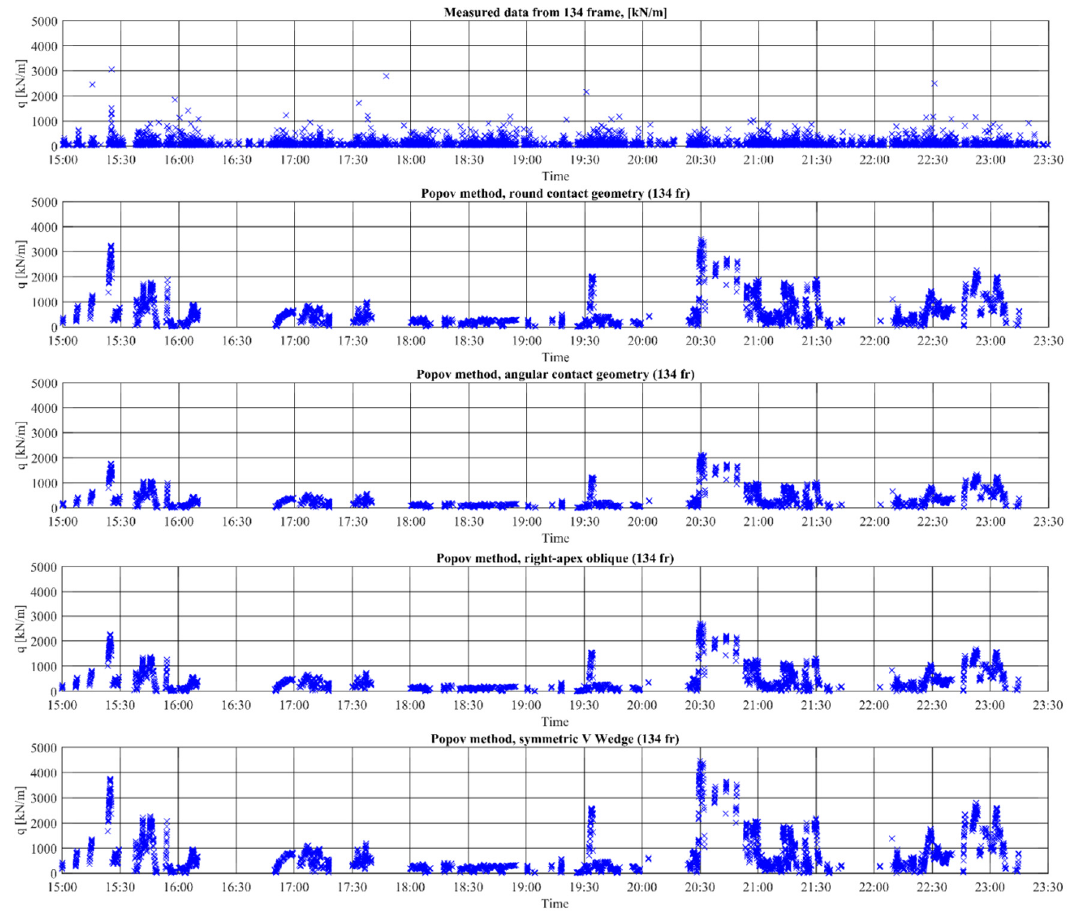
Figure 7. Measured and estimated line loads from ship–ice floe impact for data set B.